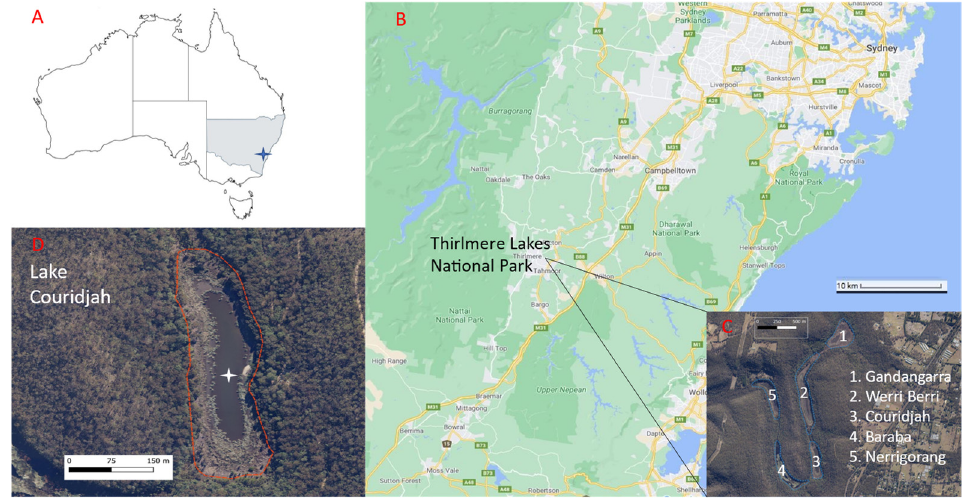
Figure 1. Location of Lake Couridjah ( D ) in relation to the Thirlmere Lakes National Park ( C ), Sydney metropolitan area ( B ) (Google Maps, 2022) and Australia (New South Wales is shaded) ( A ). The white star ( D ) marks the location where LC2 was cored.